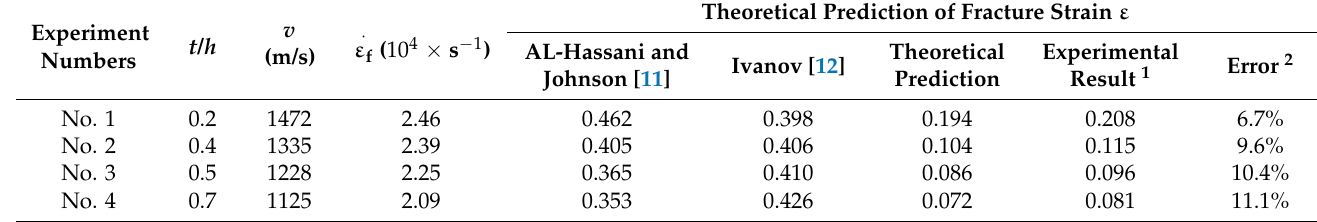
Table 3. Summary of experimental results.